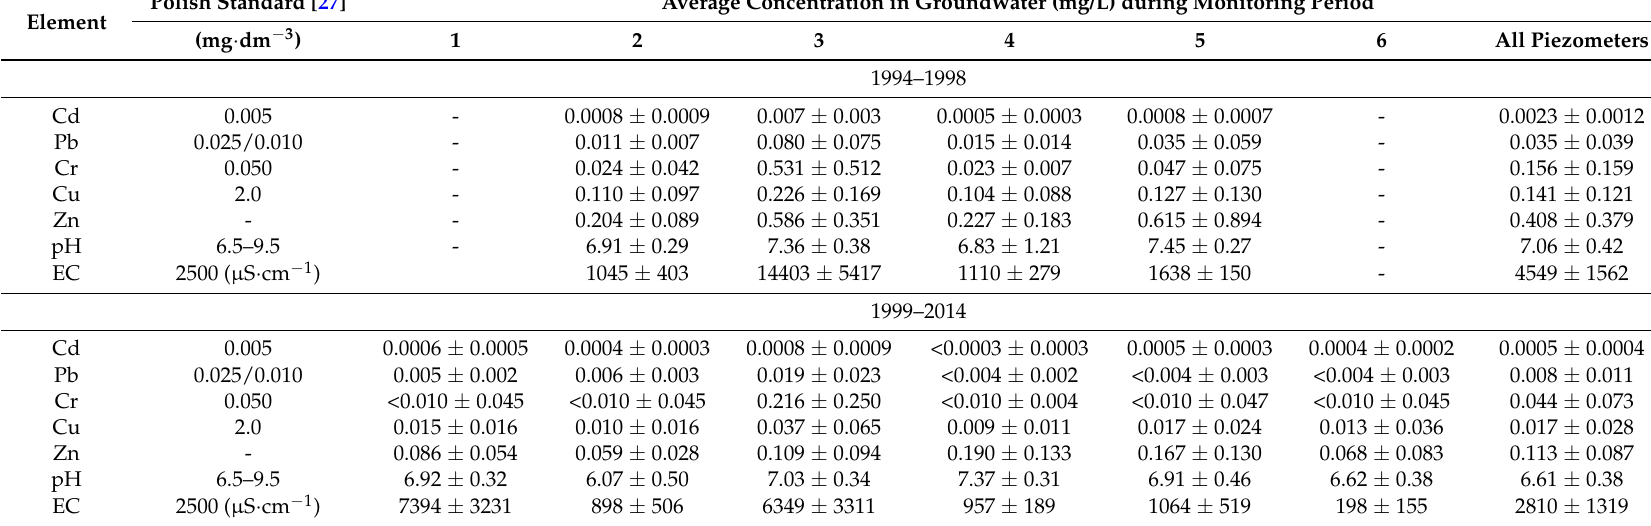
Table 1. Average values and standard deviations for concentrations of heavy metals, pH and EC in groundwater,